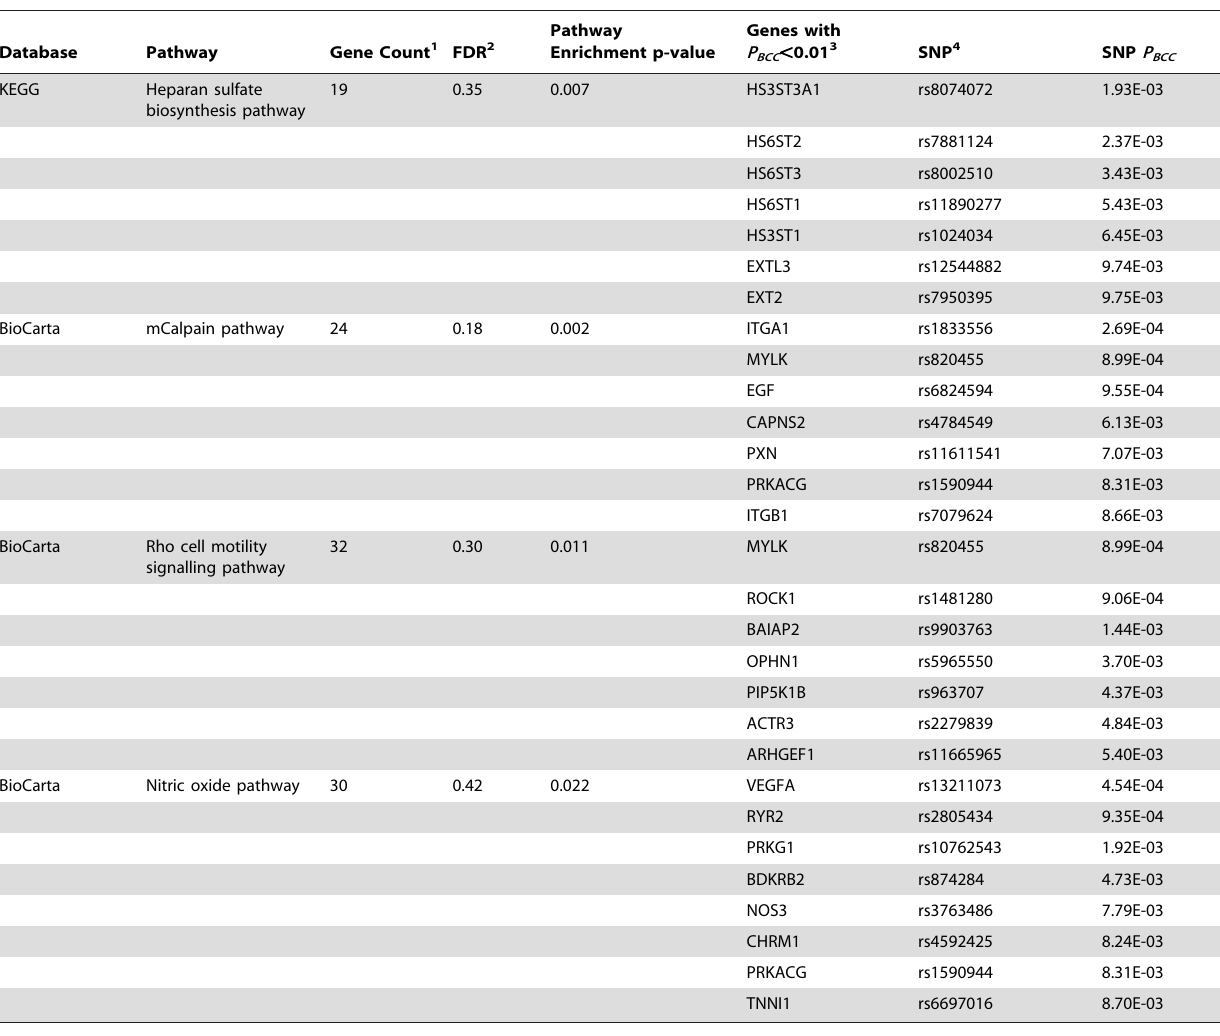
Table 1. Pathways with significant enrichment in the BCC